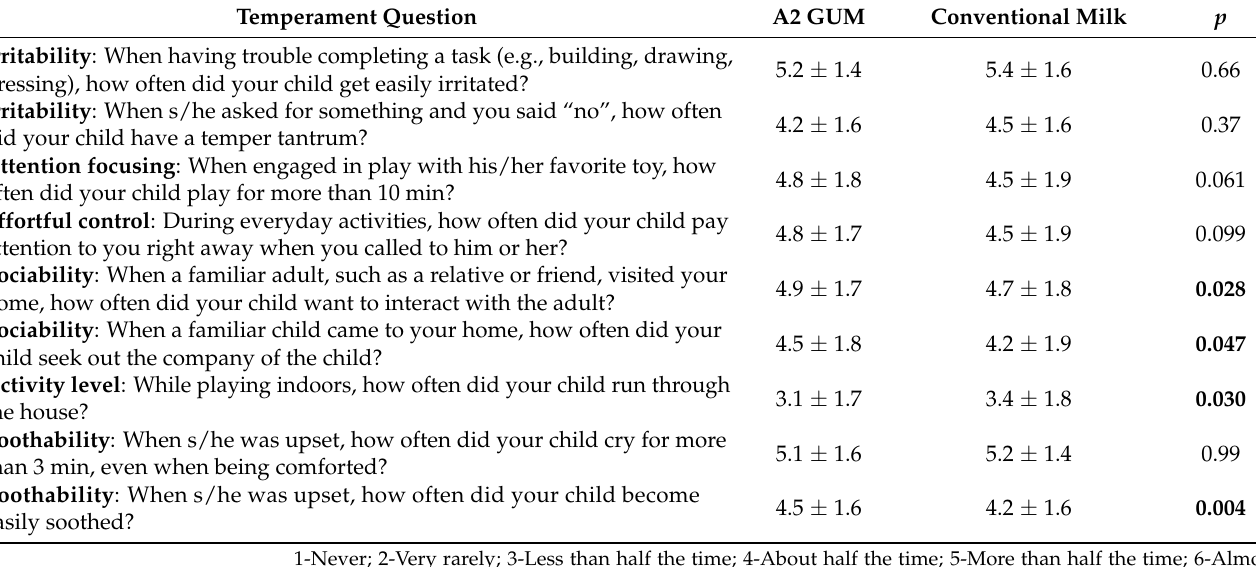
Table 3. Temperament items at day 14, by group.